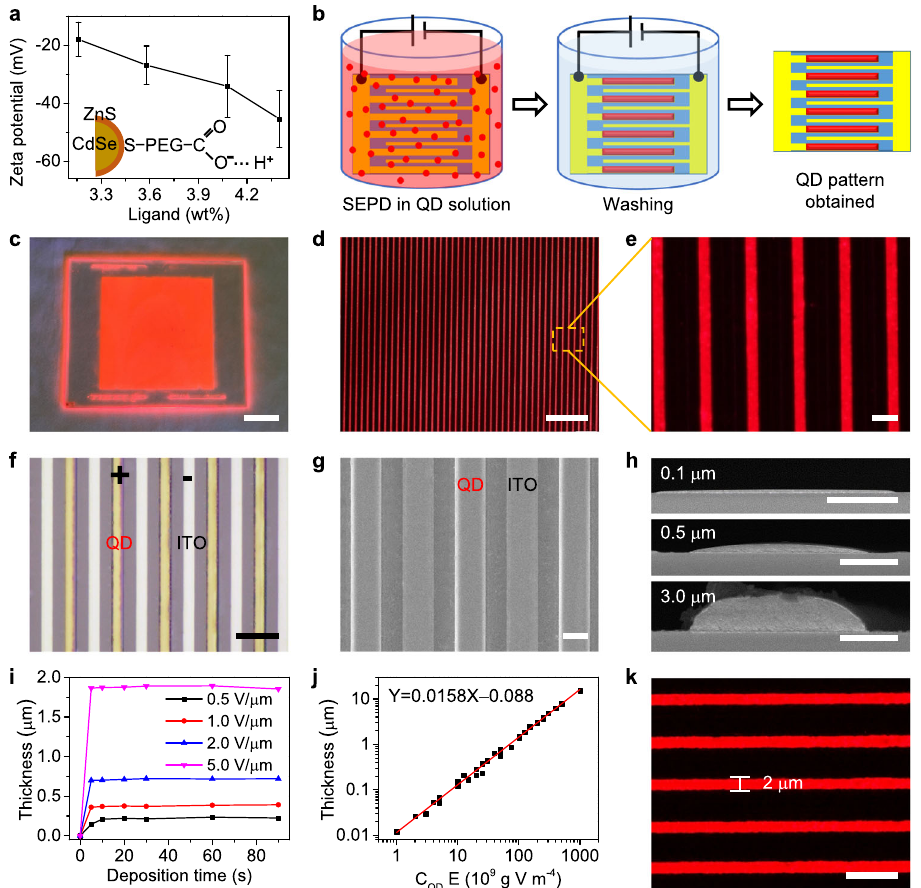
Fig. 1 Patterning of QDs array via SEPD. a Zeta potentials of QDs capped with different ligand contents. The error bars are the standard deviation in measured zeta potentials for ten runs. Inset: schematic representation of a QD with ionized surface ligands. b Schematic illustration of the QDs patterning process on the in-plane parallel electrodes substrate. c Image of large-area ordered QD stripe pattern. Scale bar, 2 cm. d , e Microscopy images of the deposited QD stripe array showing the uniform size and a well-de fi ned pattern. Scale bars are 200 and 20 μ m, respectively. f , g Bright- fi eld image and SEM image of QD pattern via SEPD. Scale bars are 50 and 10 μ m, respectively. h Cross-sectional SEM images of QD stripes with different thickness. Scale bars, 5 μ m. i Relationship between the deposited thickness of the QD stripe and deposition time at different electric fi elds. j Deposited QD stripe layer thickness as a function of electric fi eld intensity ( E ) and QDs concentrations ( C QD ) product. k Fluorescence image of QD stripe array with a linewidth of ≈ 2 µ m. Scale bar, 10 μ